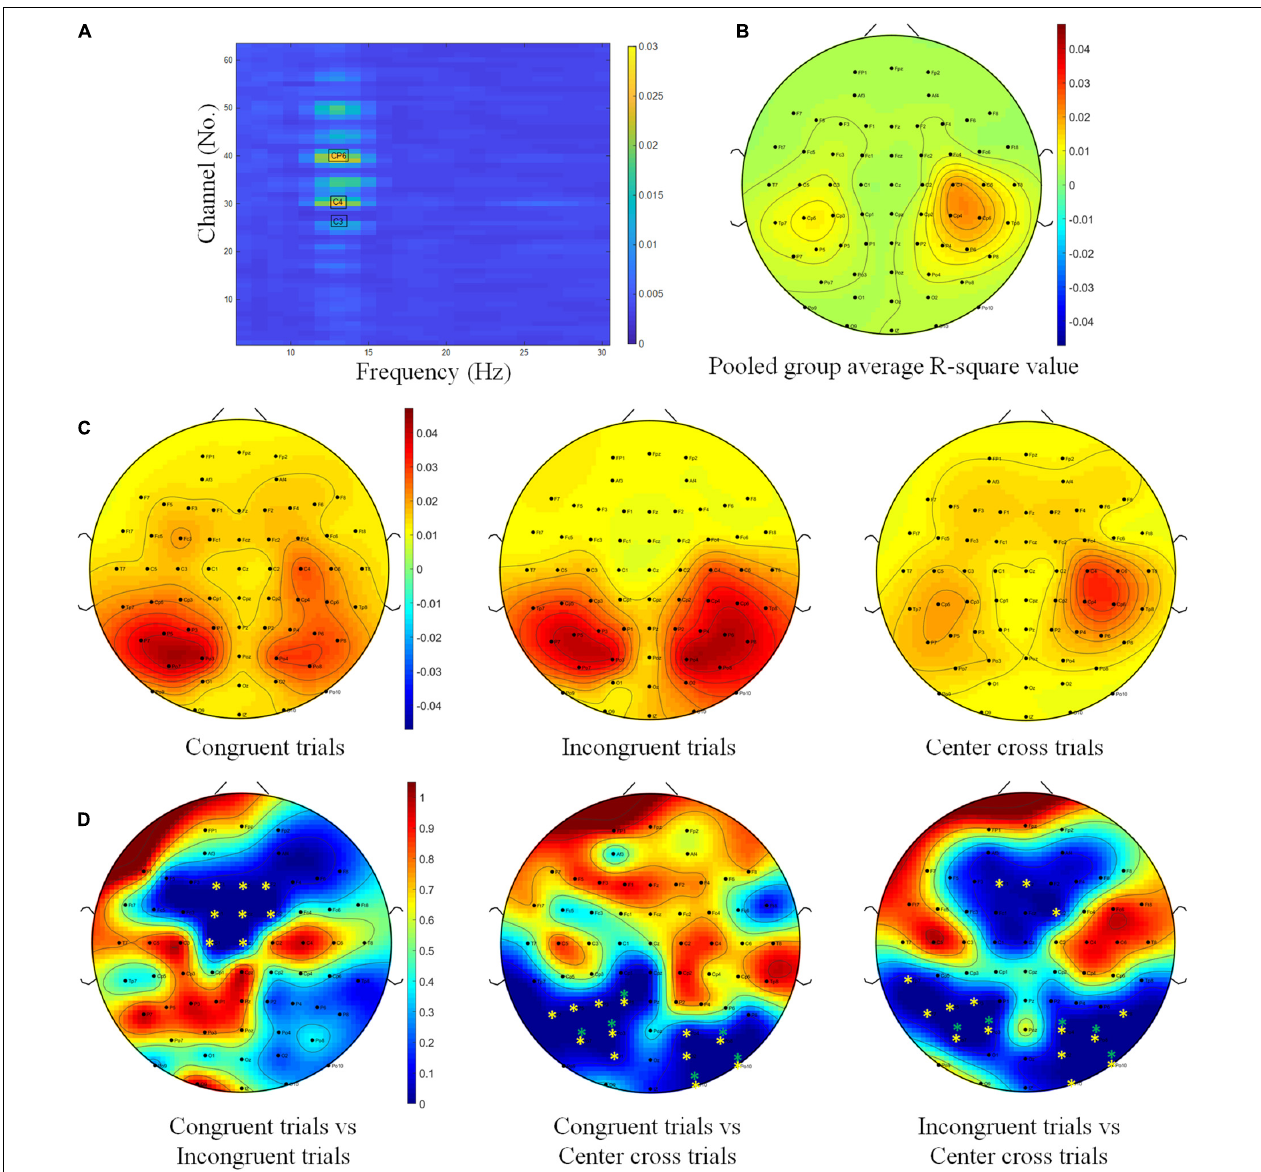
FIGURE 7 | R-square value topography maps and statistics. (A) Channel-frequency map of group average R-square values over fourteen subjects. (B) Topography of the pooled group average R-square values over fourteen subjects. (C) Topographies of group average R-square values over fourteen subjects with respect to congruent trials, incongruent trials and center cross trials. The color bar for all three topographies of this row was the same in order to have a fair comparison. (D) Contrast analysis of R-square values between congruent trials and incongruent trials, between congruent trials and center cross trials, between incongruent trials and center cross trials. The color bar for all three p -value maps was the same ( ∗ means p < 0.05, ∗∗ means p < 0.01).